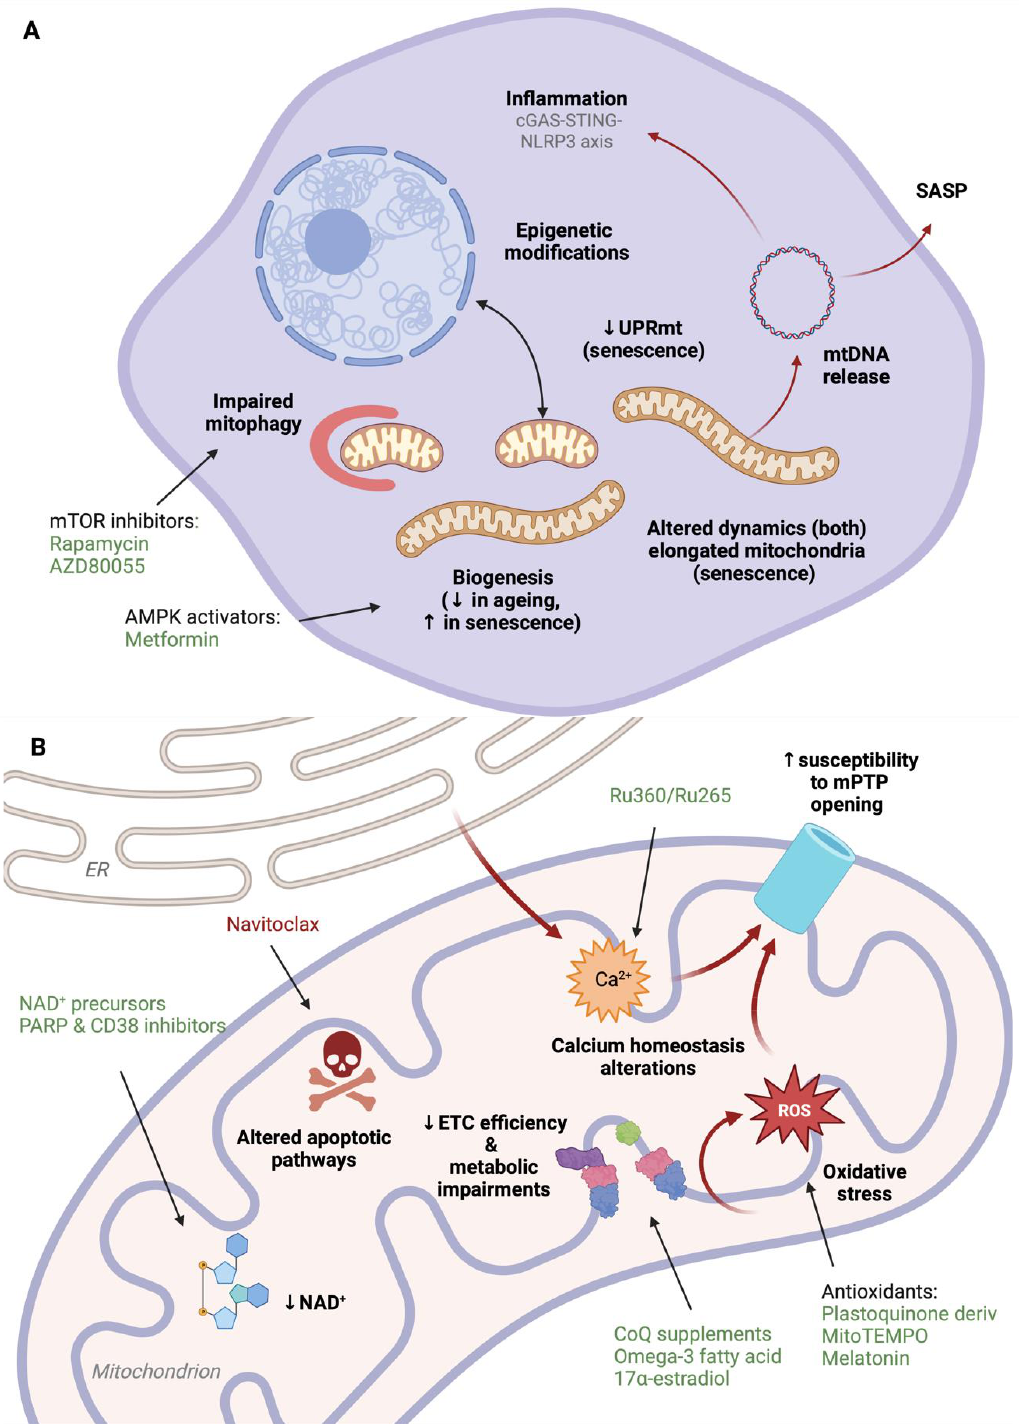
Figure 2. Mitochondrial dysfunctions are a hallmark of both ageing and cellular senescence and represent crucial targets in treating ageing-associated diseases. ( A ) Both aged and senescent cells are characterised by modifications in the mitochondrial network, dynamics, and interactions between the organelle and the rest of the cell. However, differences can be observed between the two conditions. In particular, modifications in the mitochondria-to-nucleus retrograde responses can induce different epigenetic changes in senescent versus old cells and modulate signal transcription pathways, such as the mitochondrial unfolded protein response (UPRmt), differently. Mitochondrial DNA (mtDNA)